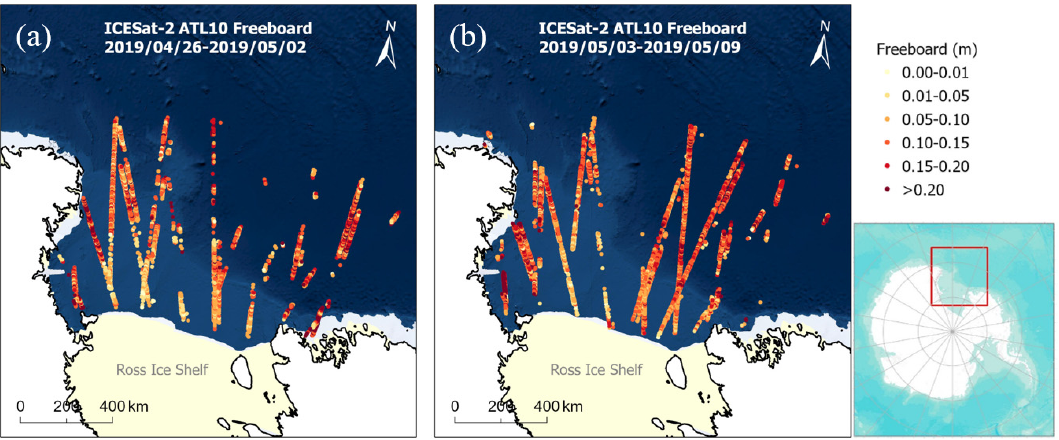
Figure 1. Actual ICESat-2 ATL10 data coverage in the Ross Sea for the following 1-week periods: ( a ) 04/26/2019–05/02/2019 and ( b ) 05/03/2019–05/09/2019. The presence of spatial gaps due to the orbit separations and existence of clouds is readily apparent.